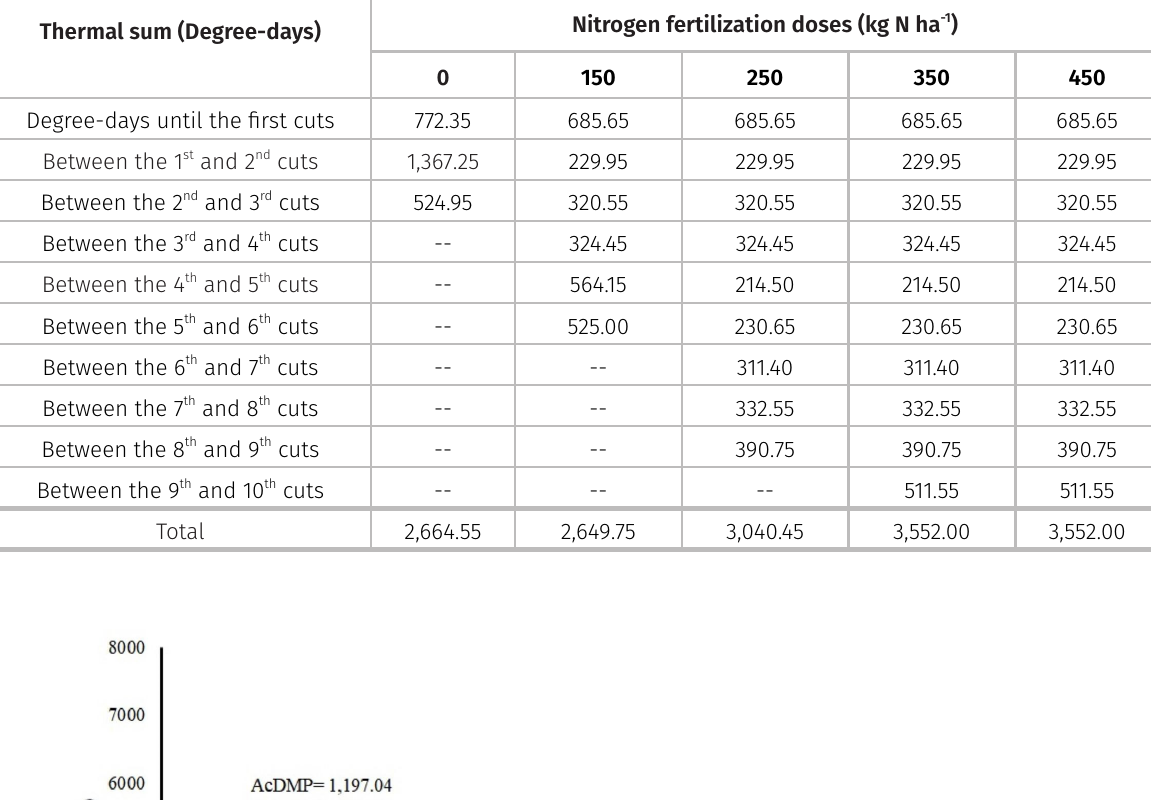
Table IV. Thermal sum expressed in degree-days for dual-purpose wheat pasture BRS Tarumã managed with different nitrogen doses.